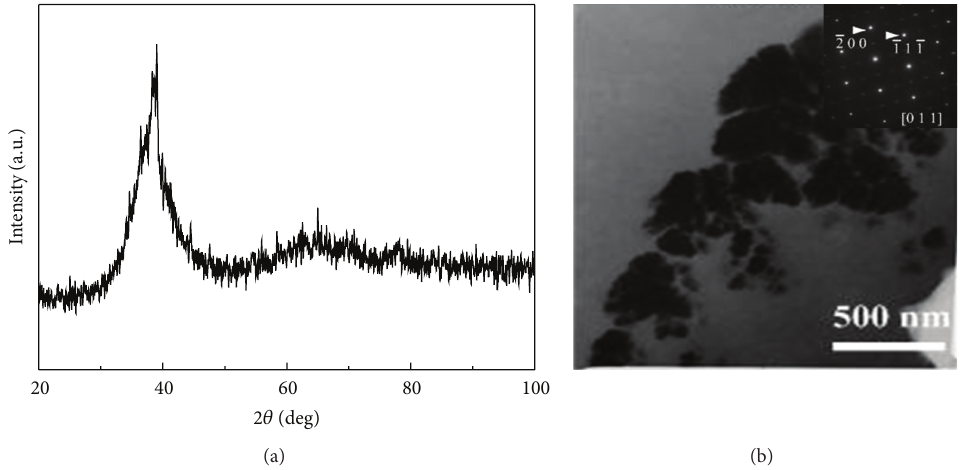
Figure 4: XRD pattern (a) and bright-field TEM image with corresponding SAED patter (b) for location